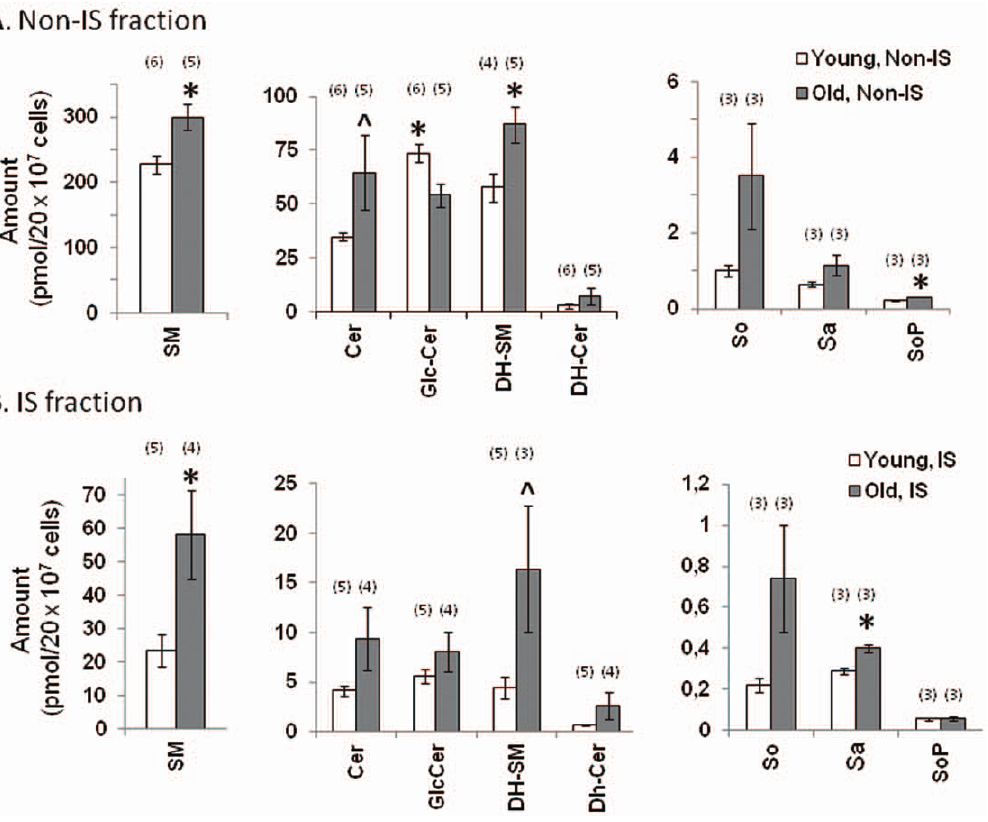
Figure 2. Although most sphingolipid classes are higher in aged CD4 + T cells, Glc-Cer are lower in aged CD4 + T cells. ( A ) Total amounts of main sphingolipid classes and long chain bases present in bead-depleted sonicates of bead-stimulated cells (non-IS fractions). White bars indicate results for young CD4 + T cells. Gray bars show results for old CD4 + T cells. Data is presented by sphingolipid category as the mean picomoles 6 SEM detected in sonicates from 20 6 10 6 cells. Two independent experiments were performed. In each experiment, three independent pools of T cells were prepared, stimulated, and sonicated. Each sonicate was subjected to sphingolipidomic analysis. The numbers in parenthesis above the bar graphs indicate the number of biological replicates included for the final analysis of each sphingolipid category and age group. P values were based on this number. (* p , 0.05, ‘ p , 0.1 between age groups). ( B ). Total amounts of main sphingolipid classes and long chain bases present in CD4 + T cell IS fractions. White bars indicate results for young CD4 + T cells. Gray bars show results for old CD4 + T cells. Data is presented by sphingolipid category as the mean picomoles 6 SEM detected in IS fractions from 20 6 10 6 cells. These samples were prepared from the same pools used in figure 2A, and analyzed in parallel. The material analyzed here corresponds to the bead enriched (IS) fraction, whereas the material in figure 2A corresponds to the bead-depleted (non-IS) fraction. The numbers in parenthesis above the bar graphs indicate the number of biological replicates included for the final analysis of each sphingolipid category and age group. P values were based on this number. (* p , 0.05, ‘ p , 0.1 between age